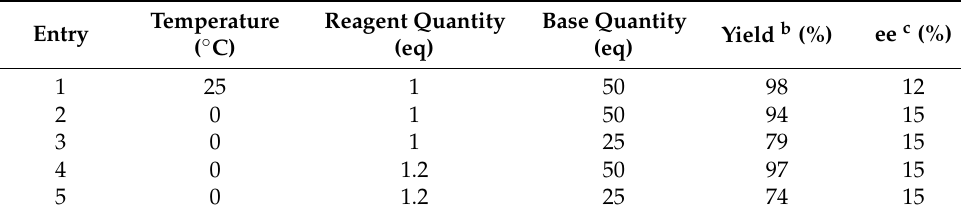
Table 4. Examination of the effect of temperature and quantities of reagent and base in the presence of catalyst C5 a